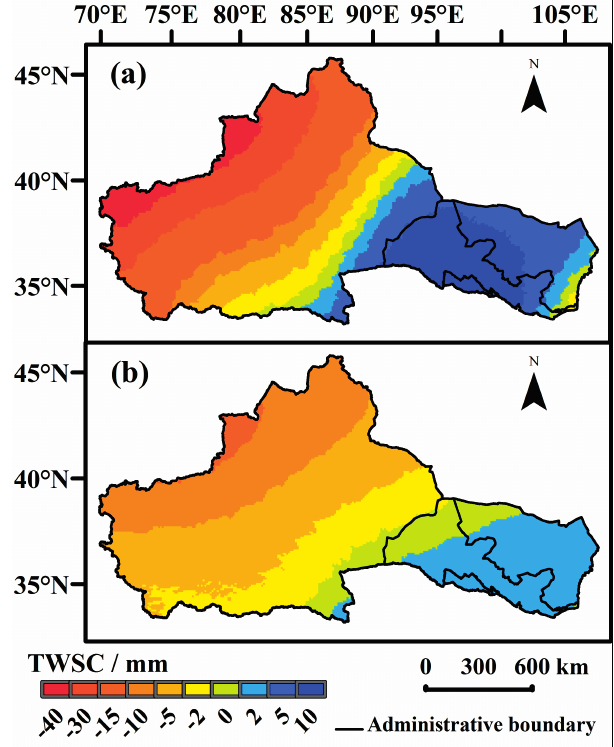
Figure 4. Spatial patterns of monthly averaged TWSC during 2008 and 2009. ( a ) GRACE; ( b ) hydrological